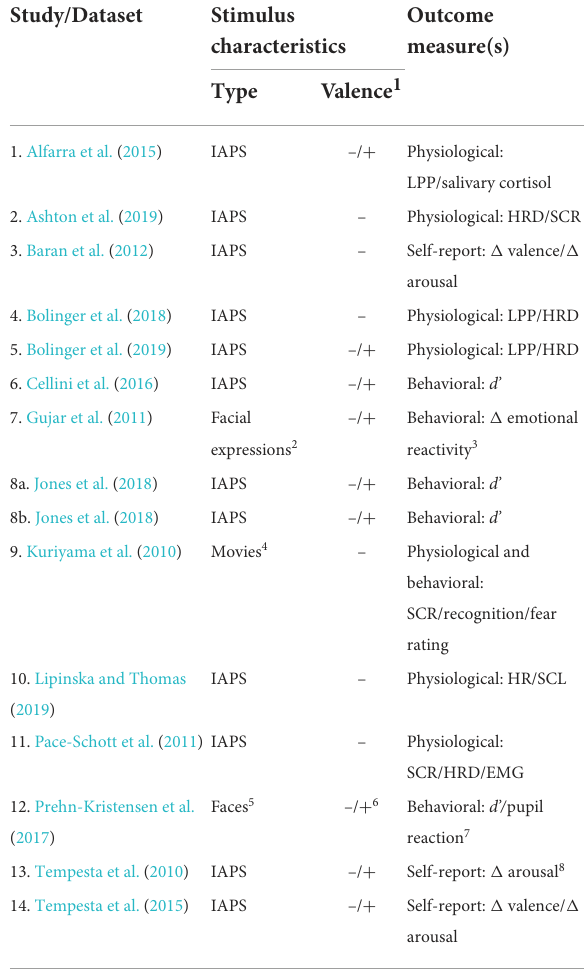
TABLE 2 Datasets included in the meta-analysis: Study stimulus characteristics and outcomes ( N = 14).